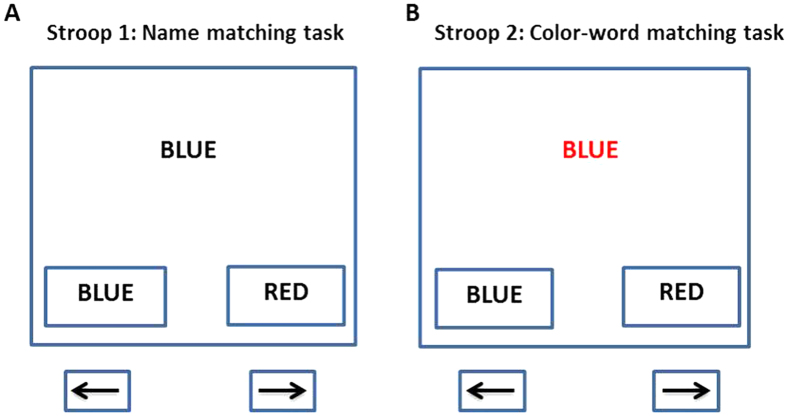
Examples of Stroop trials used in this study.(A) Stroop1 (i.e., neutral Stroop task) trial: Participants should match the word name given at the center of the screen to word name given in options at bottom of the screen, by pressing the appropriate left or right arrow key. (B) Stroop2 (i.e., incongruent Stroop task) trial: Participants should match the ink color of the word given at the center of the screen to word name given in options at the bottom of the screen, by pressing the appropriate left or right arrow key.